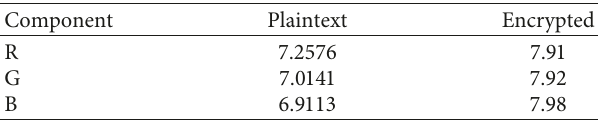
Table 3: The local Shannon entropy